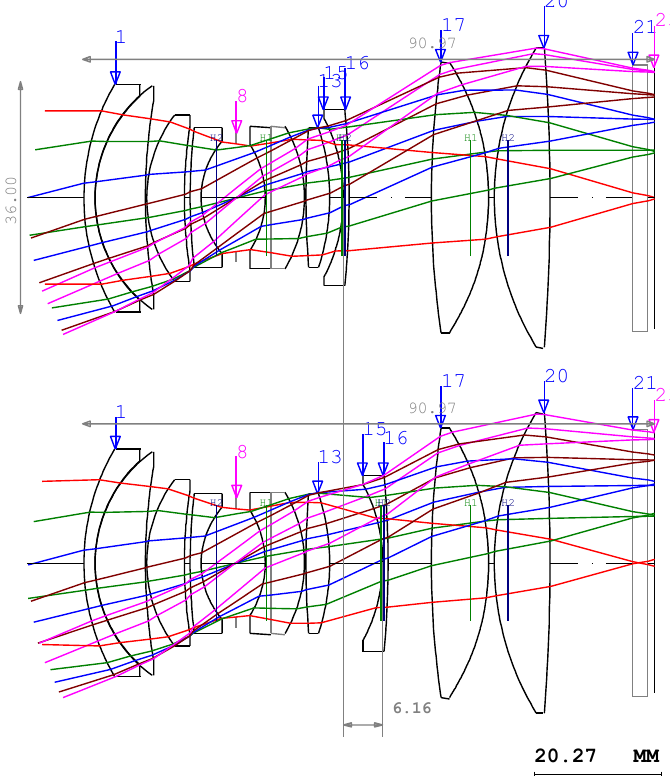
Figure 3. Optical layout of the designed double-Gauss lens.